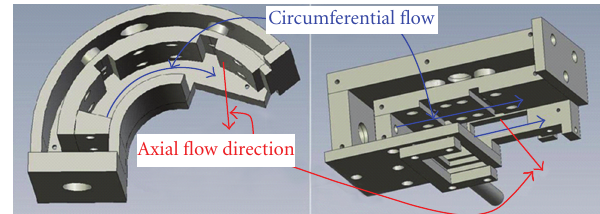
Figure 3: Showing the curved combustion channel versus the straight combustion channel, indicated circumferential flow is the primary flame